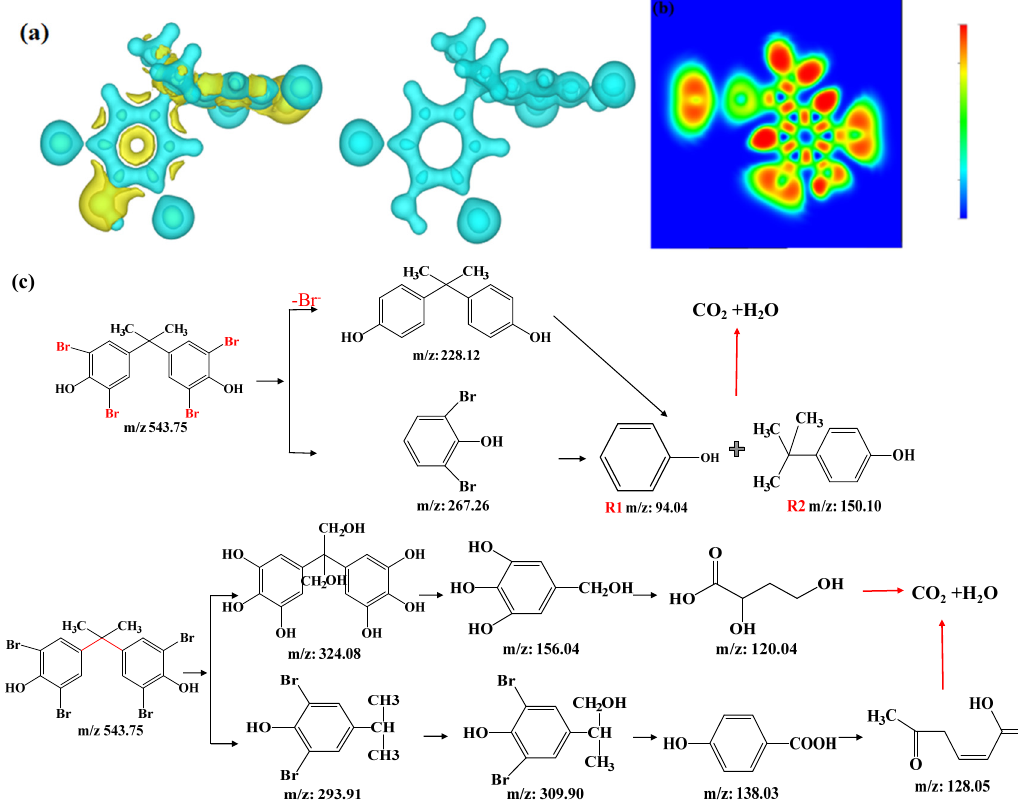
Figure 8. Electron density Laplacian analysis ( a ), projection map of electron localization function ELF ( b ) of TBBPA, and proposed TBBPA degradation pathways ( c ).